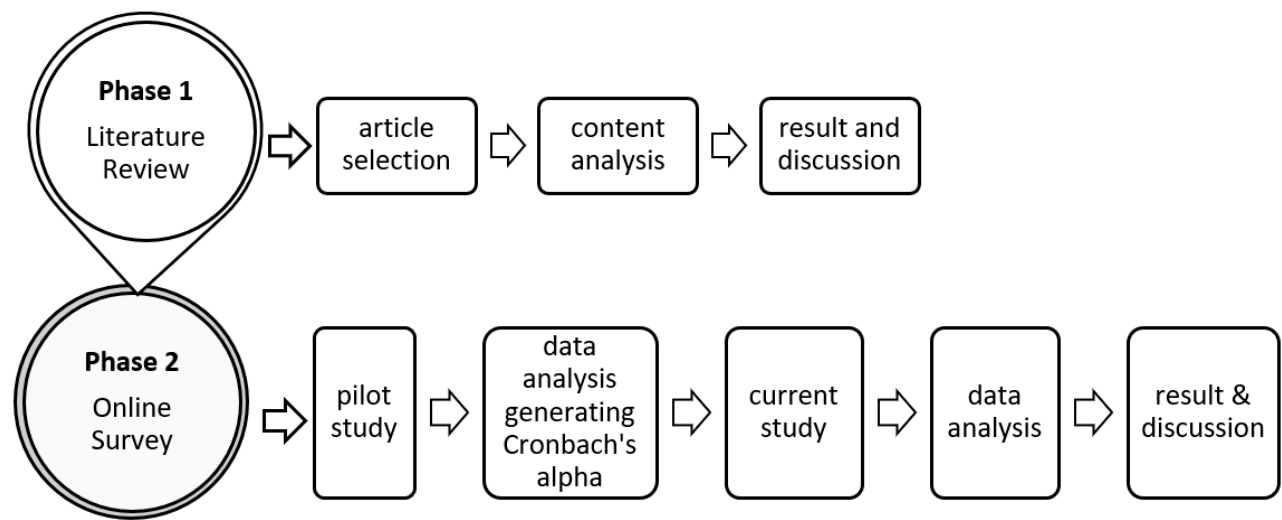
Figure 1. Methodogy system flow.